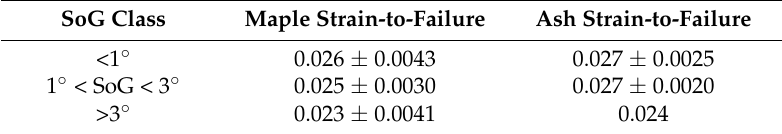
Table 2. Mean maple and ash sample strain-to-failure results sorted by SoG class.